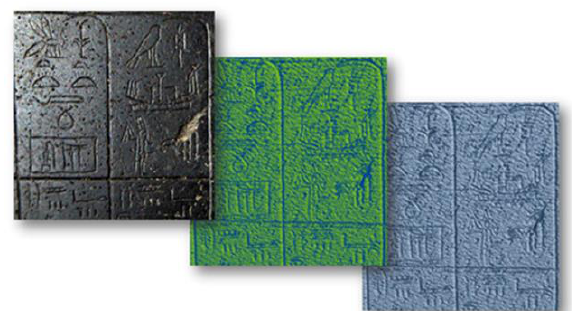
Figure 7: Surface detail of the Palermo Stone. Comparison between the photo and the